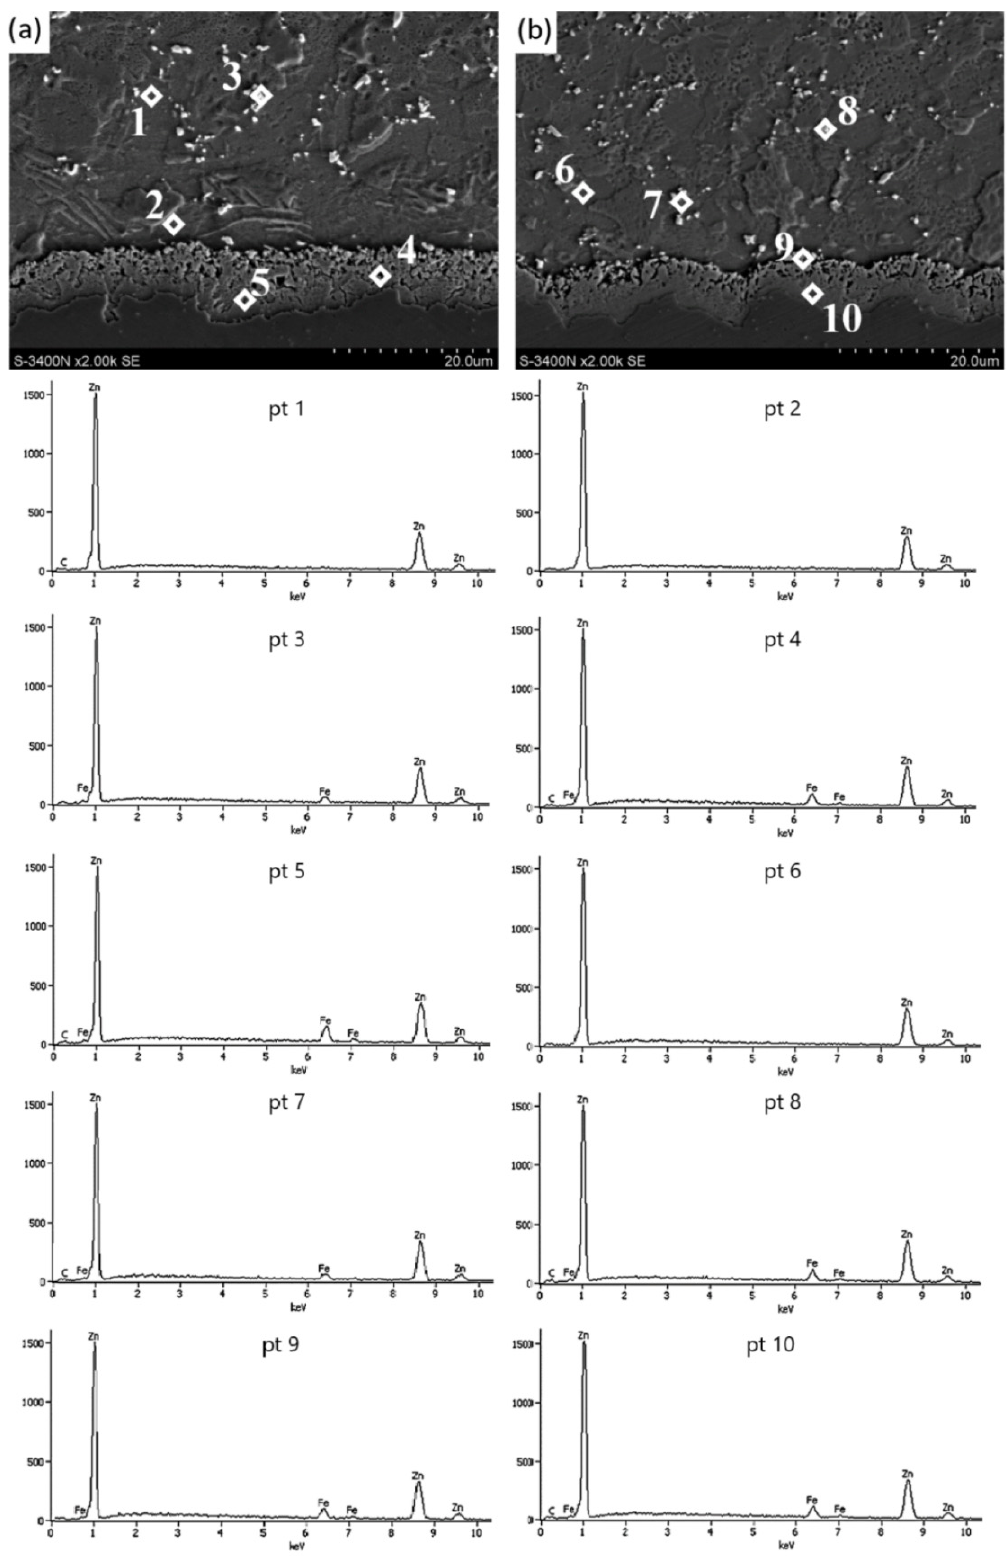
Figure 2. The (SEM) coating microstructure and the EDS X-ray spectral analysis in the micro-areas of the coating on the wire cross-section from variants ( a ) K5 and ( b ) H5.